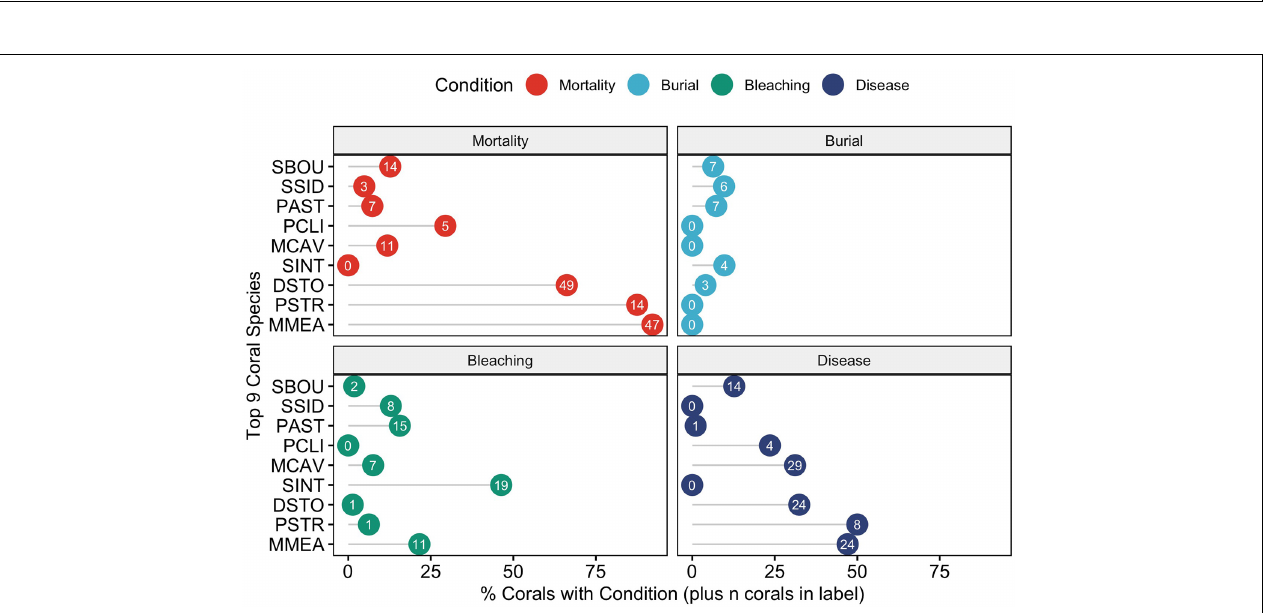
Frontiers in Marine Science |